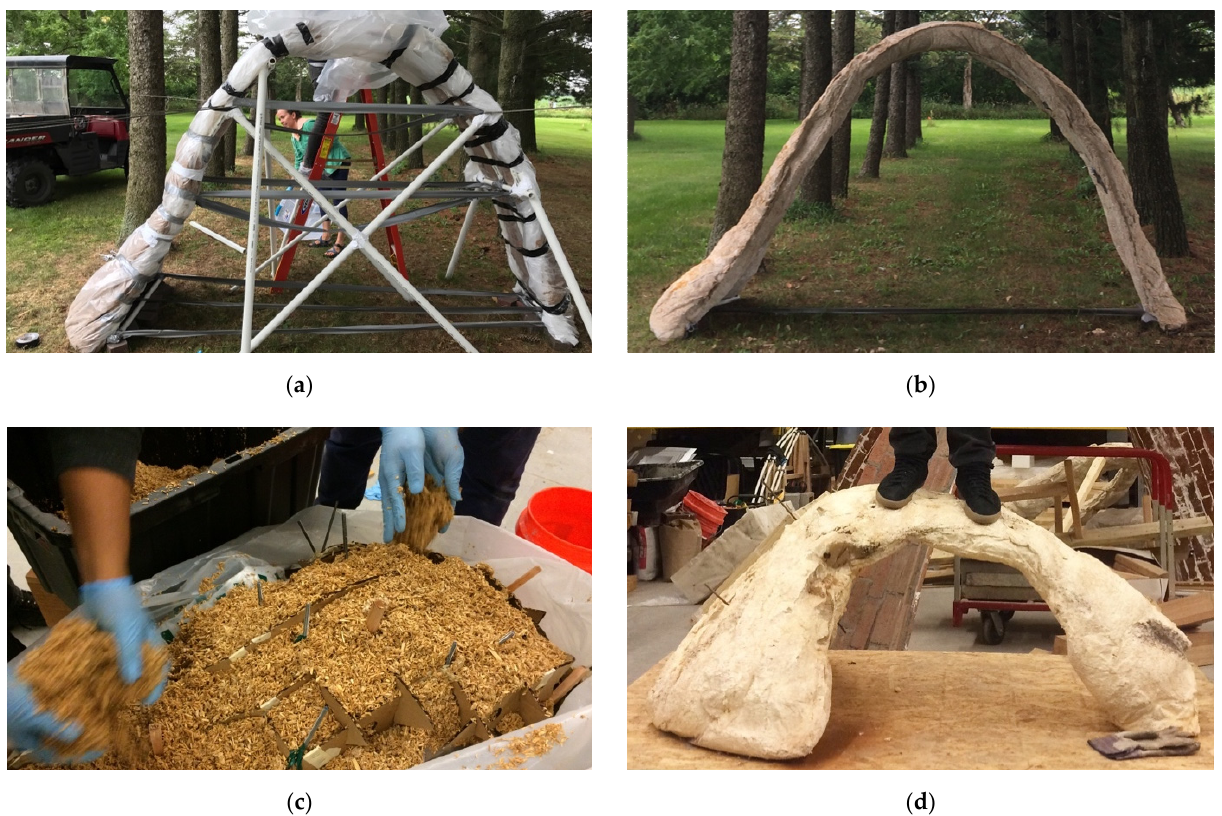
Figure 1. ( a ) Formwork for the “Mycoarch” composed of active bent PVC and plastic sheeting; ( b ) completed arch (late 2017, since renamed the “Diamond A Arch”), which collapsed due to inaccurate form and a myco-material matrix that had not sufficiently dried; ( c ) packing the internal reinforcing for the “Thick and Thin Arch” composed of recycled cardboard; ( d ) complete “Thick and Thin Arch” (early 2018) held seventy-five kilograms. Photos by the author.